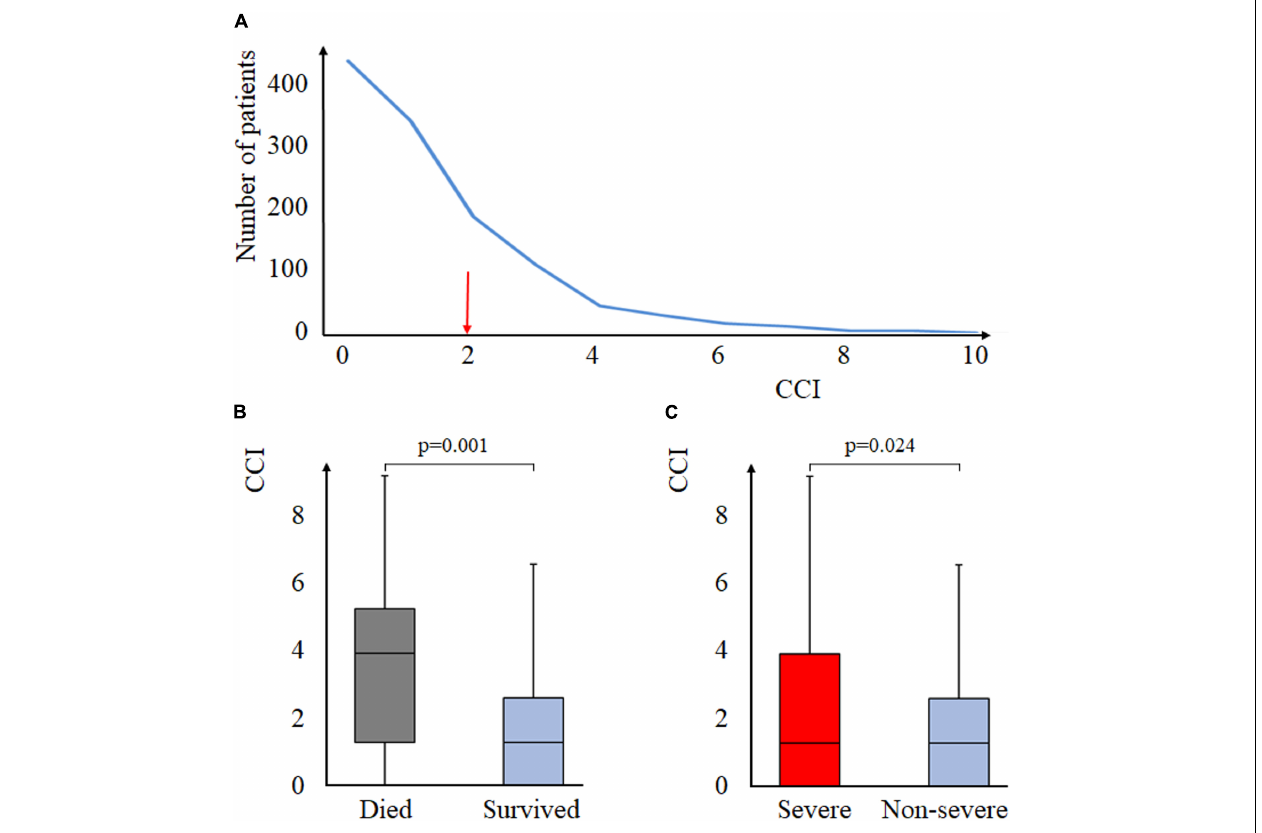
FIGURE 2 | Charlson Comorbidity Score and AP. (A) distribution of CCI in the study population, the red arrow indicates the median CCI of the population. (B) mortality and CCI (Mann–Whitney test). (C) severity and CCI (Mann–Whitney test). CCI, Charlson Comorbidity Index.